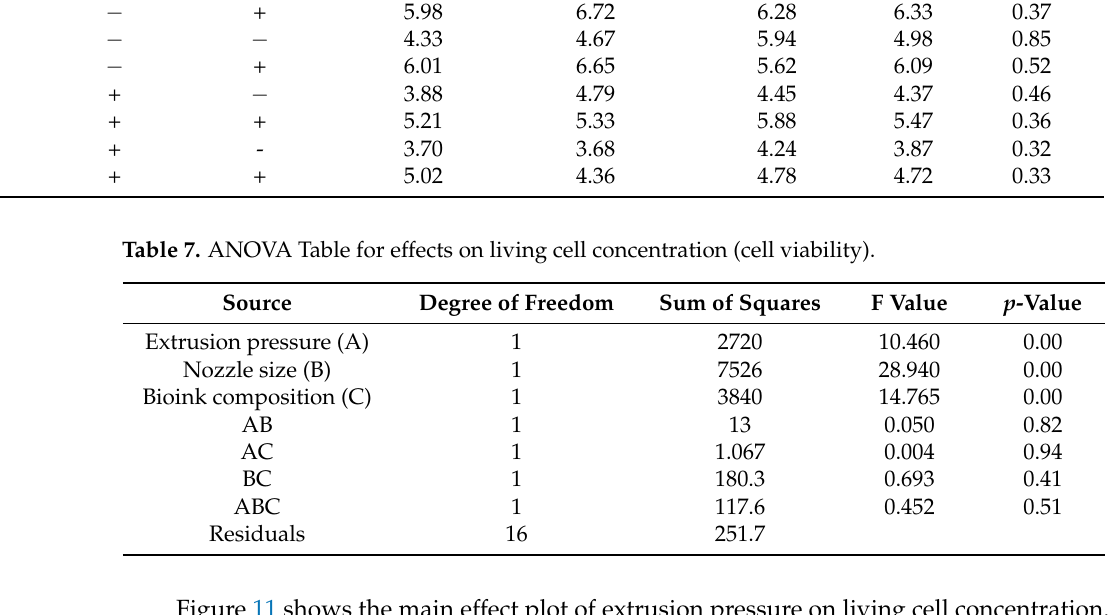
Figure 10. Interaction effect on perimeter deviation of extrusion pressure, nozzle size, and bioink composition.